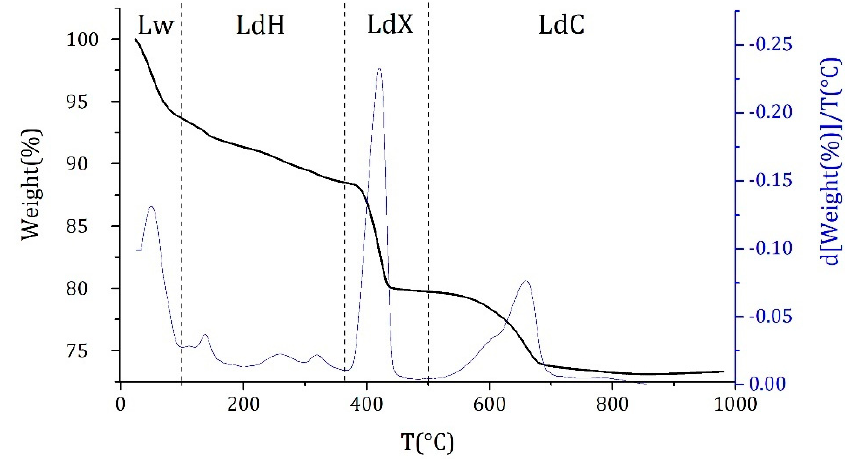
Figure 4. TGA/DTG plot of a lime paste and ranges of temperature related to the principal phenom- ena occurring in the sample (see text). ena occurring in the sample (see